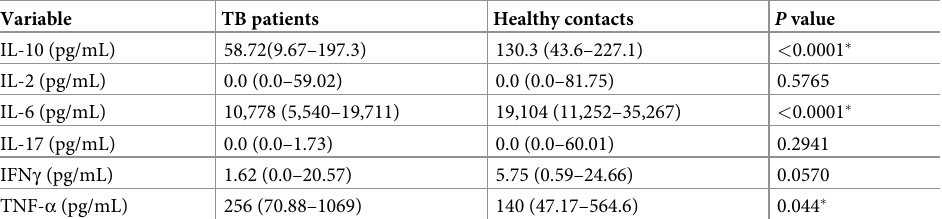
Table 2. Expression of TH1 and TH2 cytokines in TB patients vs healthy contacts. Variable TB